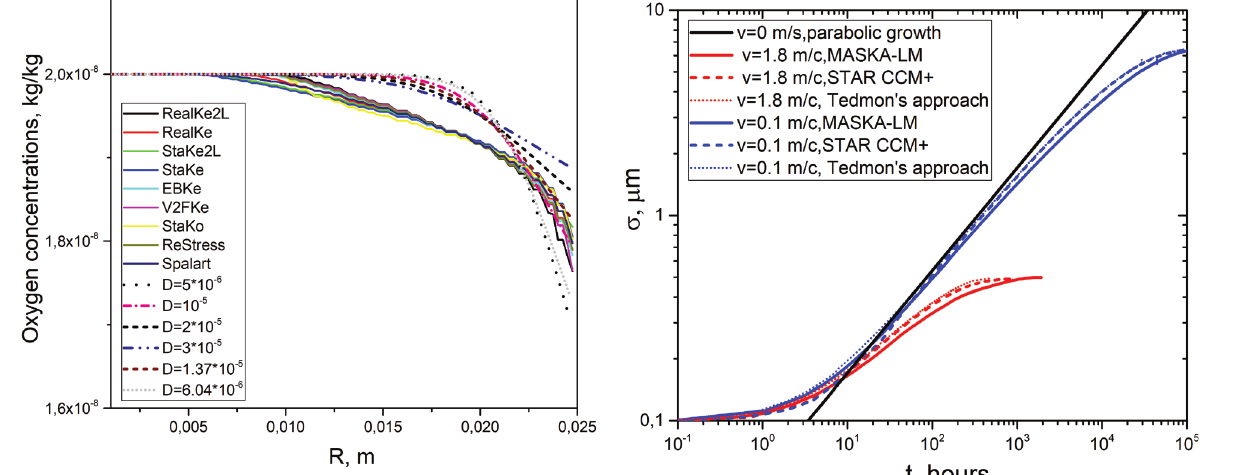
Figure 15. Results of calculations of film growth carried out in the framework of MASKA-LM, STAR-CCM+ and the ana - lytical solution of the Tedmon’s approach at a temperature T = 500 o C. Mass oxygen content – 10 -8